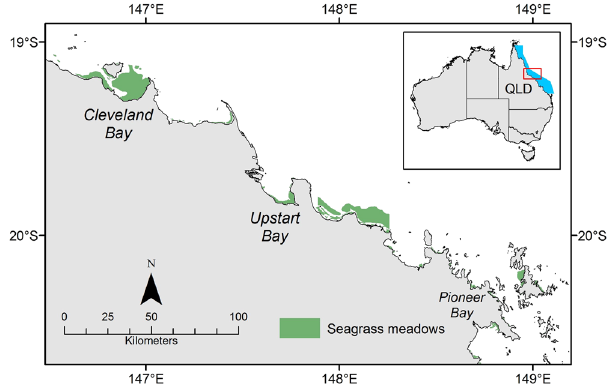
Figure 4. Map of intertidal seagrass meadows (green) in the central Great Barrier Reef, Queensland (QLD) Australia where mega-herbivore faecal matter samples were collected between September and December 2014. The inset map shows the location of the central region (red box) of the Great Barrier Reef World Heritage Area (blue). The map is overlayed with a subset of current known seagrass meadows (available from http://eatlas.org. au/data/uuid/77998615-bbab-4270-bcb1-96c46f56f85a). This map was created using ArcGIS v10.3 software by Esri software (http://www.esri.com/software/arcgis/new). ArcGIS and ArcMap are the intellectual property of Esri and are used herein under